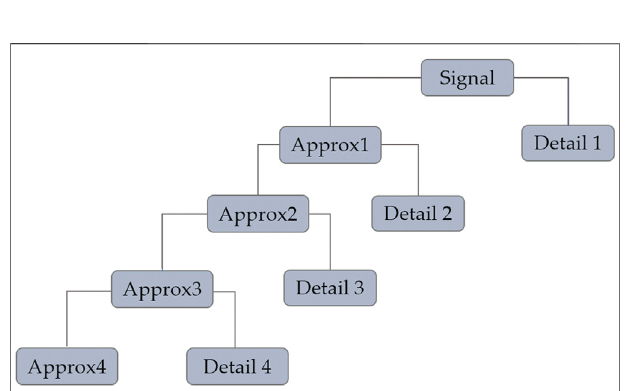
FIGURE 3 | Schematic discrete wavelet transforms for the four-level Symlet wavelet decomposition used in this work.